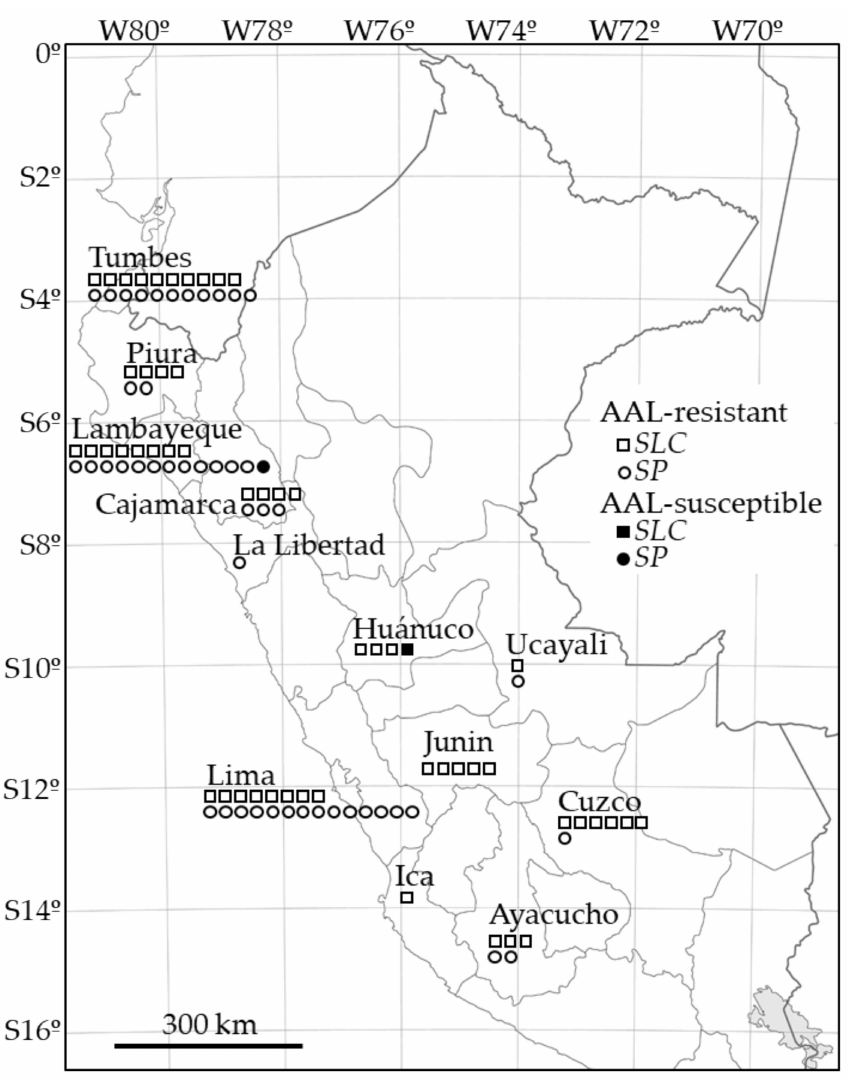
Figure 1. Map of the collection sites of Peruvian tomato accessions. Squares shown within each province represent accessions of Solanum lycopersicum var. cerasiforme ( SLC ) and circles represent S. pimpinellifolium ( SP ) from the UNALM-TUAT Collection and the INIA Collection (Table 1). Each black square and circle shows an AAL-toxin susceptible accession. Map from Aflo Co. [19] and